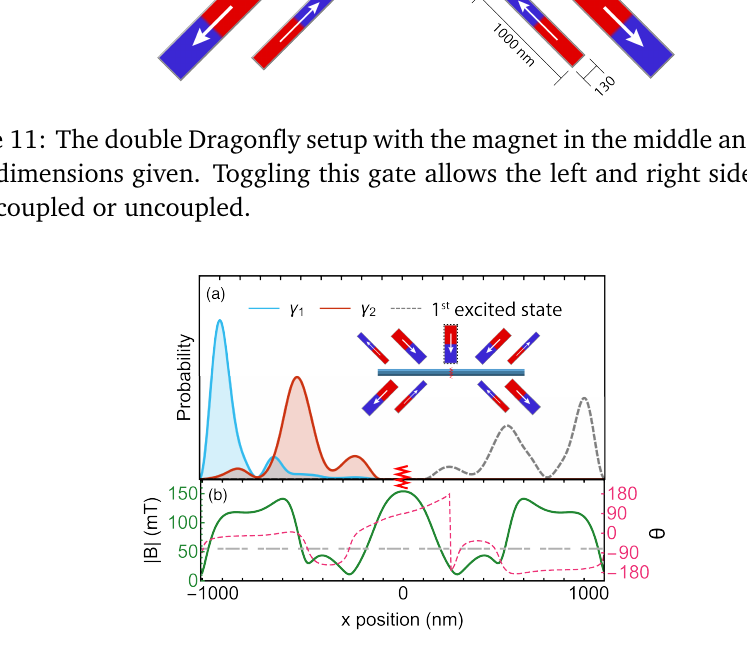
Figure 12: (a) Probability distributions for two lowest energy states for double Drag- onfly setup with the 9th magnet and the gate closed (inset). The probability distribu- tions shows two separate pairs of MZMs in each section of the wire, the left is shown / ∆ = 3.1 × 10 − 2 (red and cyan), the other pair in the Majorana basis with energy E 1 / ∆ = 3.1 × 10 − 2 in the right section is in the electronic state basis with energy E 2 / ∆ = 8.9 × 10 − 1 . (b) (black- dashed line). The third state is well separated at E 3 Field profile along wire. External field is 40mT in positive